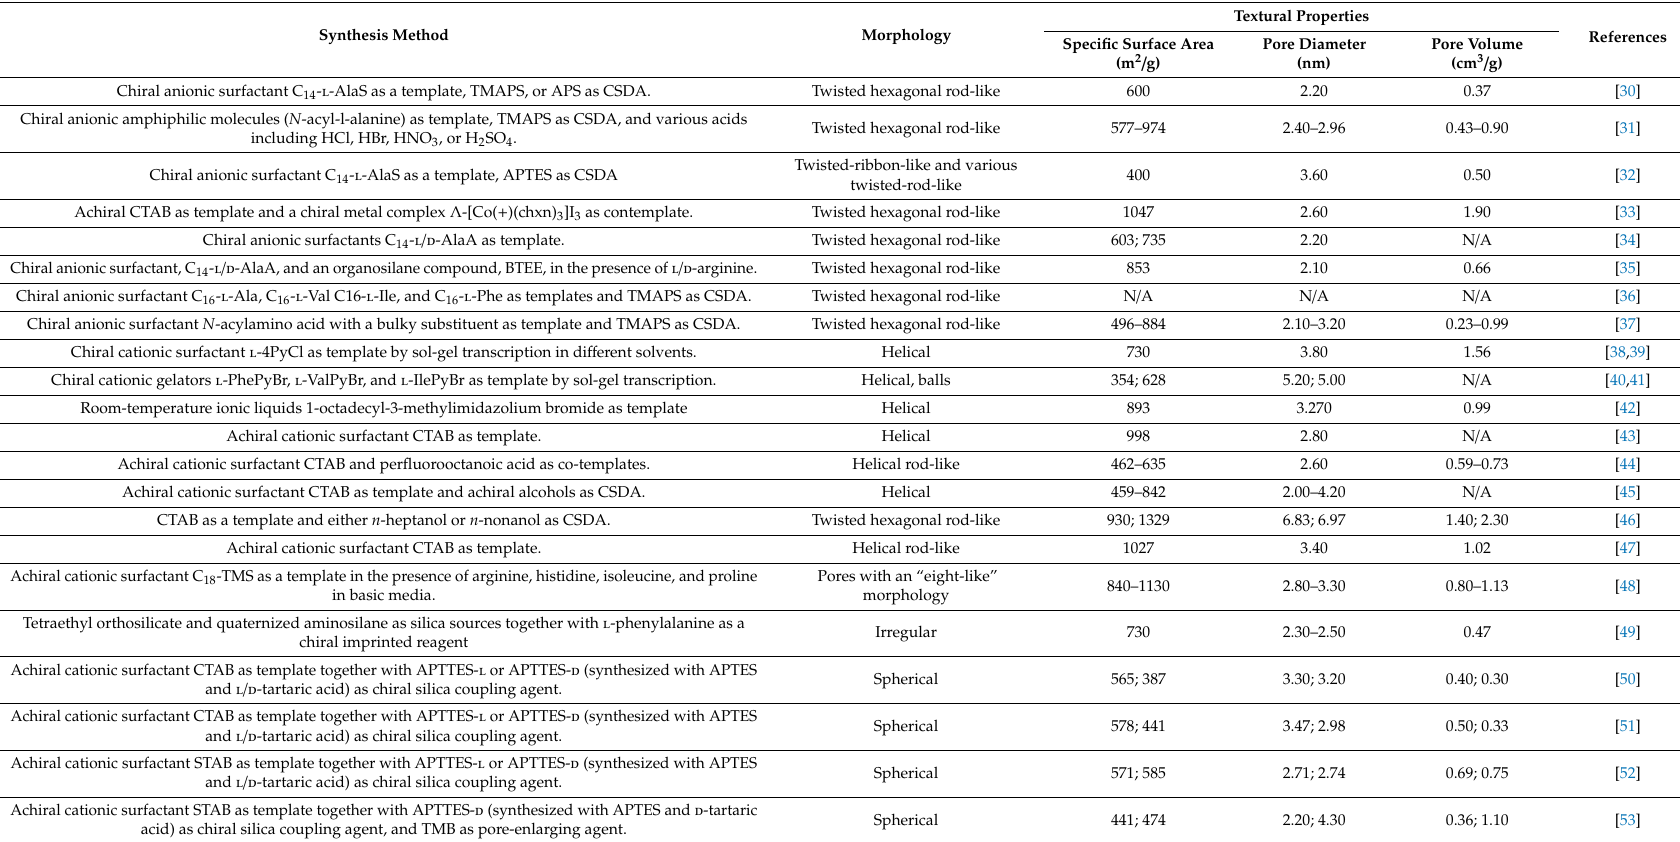
Table 1. The synthesis method, morphology, and textural properties of chiral mesoporous